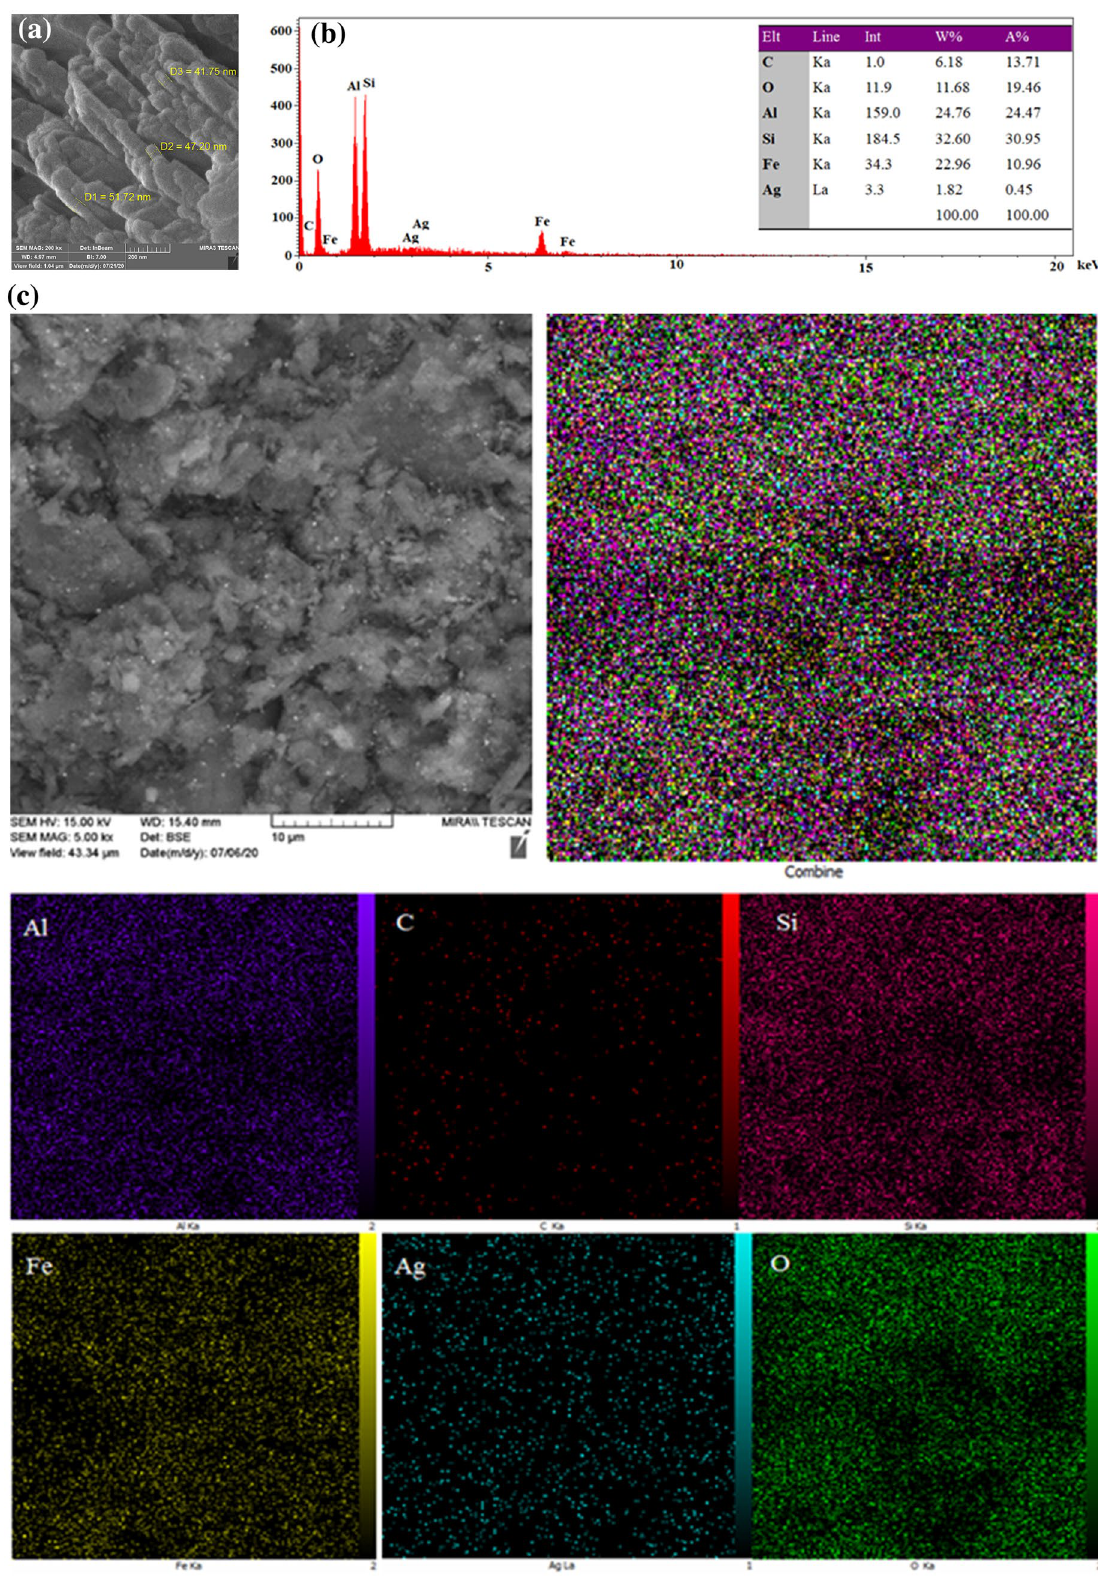
Figure 4. ( a ) FESEM images, ( b ) EDS, ( c ) Mapping of HS-Alginate-Ag/Fe 3 O 4